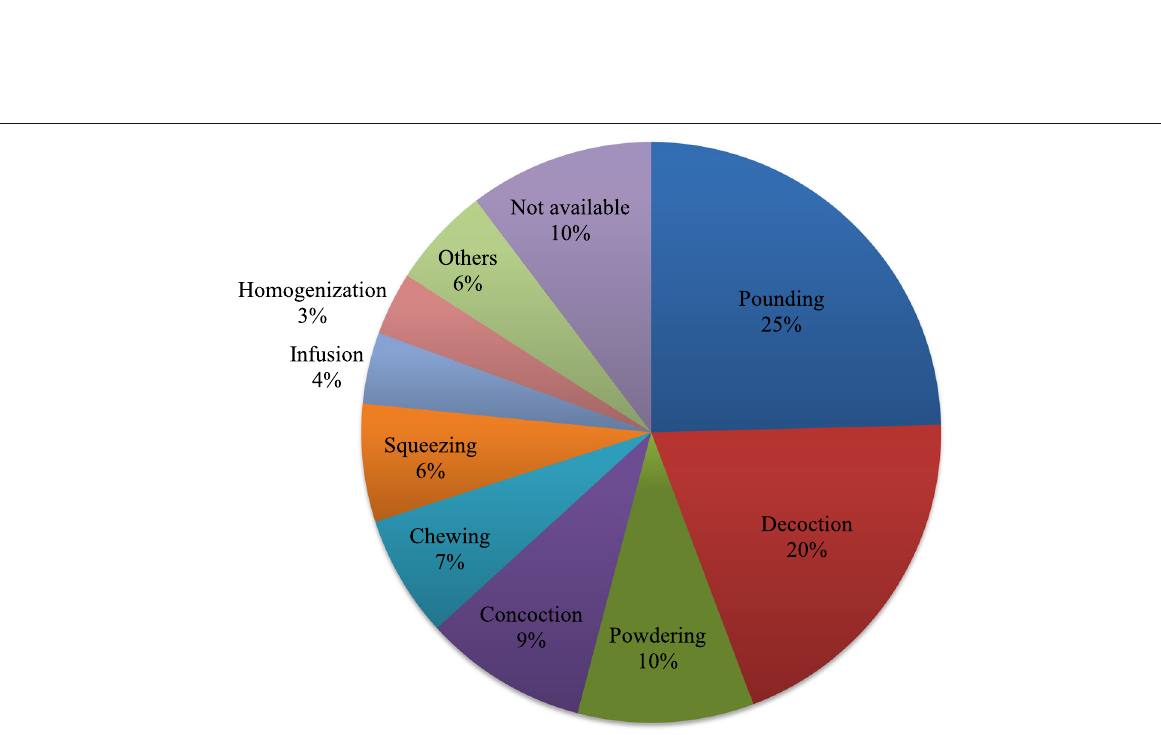
Fig. 5 Methods of preparation of plants used for the treatment of hepatic disorders in Ethiopia